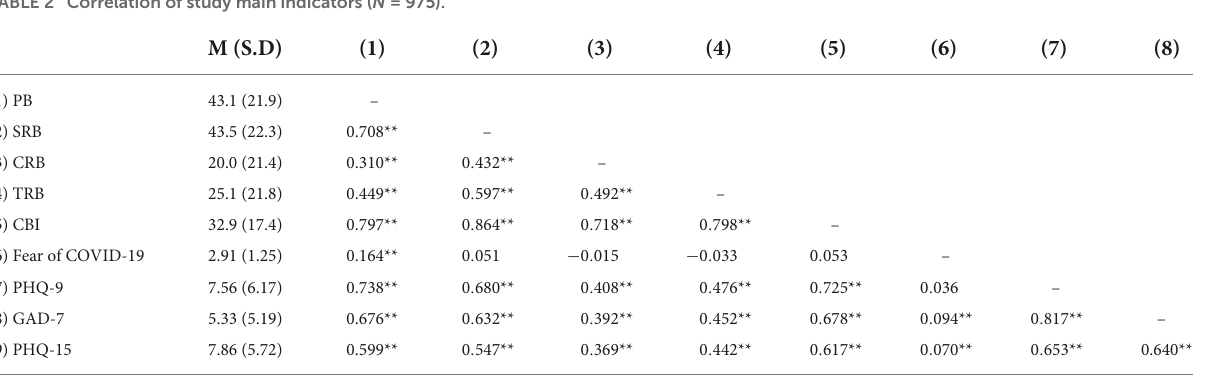
TABLE 2 Correlation of study main indicators ( N =